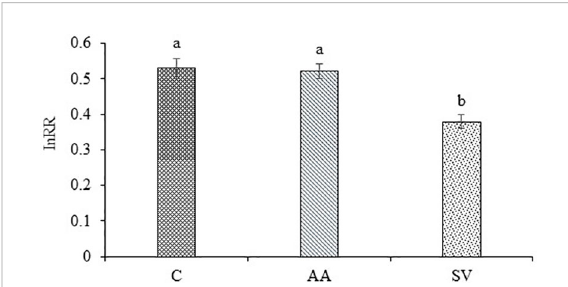
FIGURE 3 Effects of competition on InRR of A. artemisiifolia and S. viridis . C, control; AA: Bacillus from the rhizosphere soil of A. artemisiifolia ; SV: Bacillus from the rhizosphere soil of S. viridis . Different lowercase letters indicate signi fi cant differences among inoculation of different Bacillus at P <0.05. Error bars represent ±SD of mean ( n